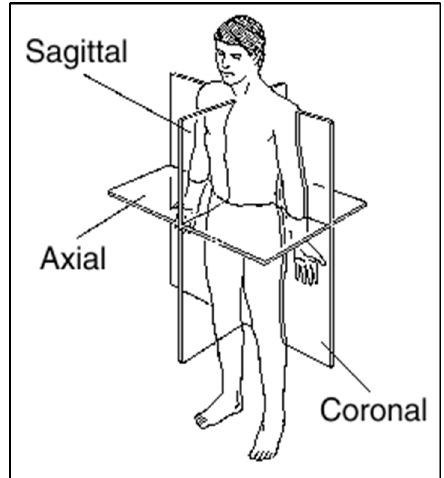
Figure 2. 3D Axis set of the human body.